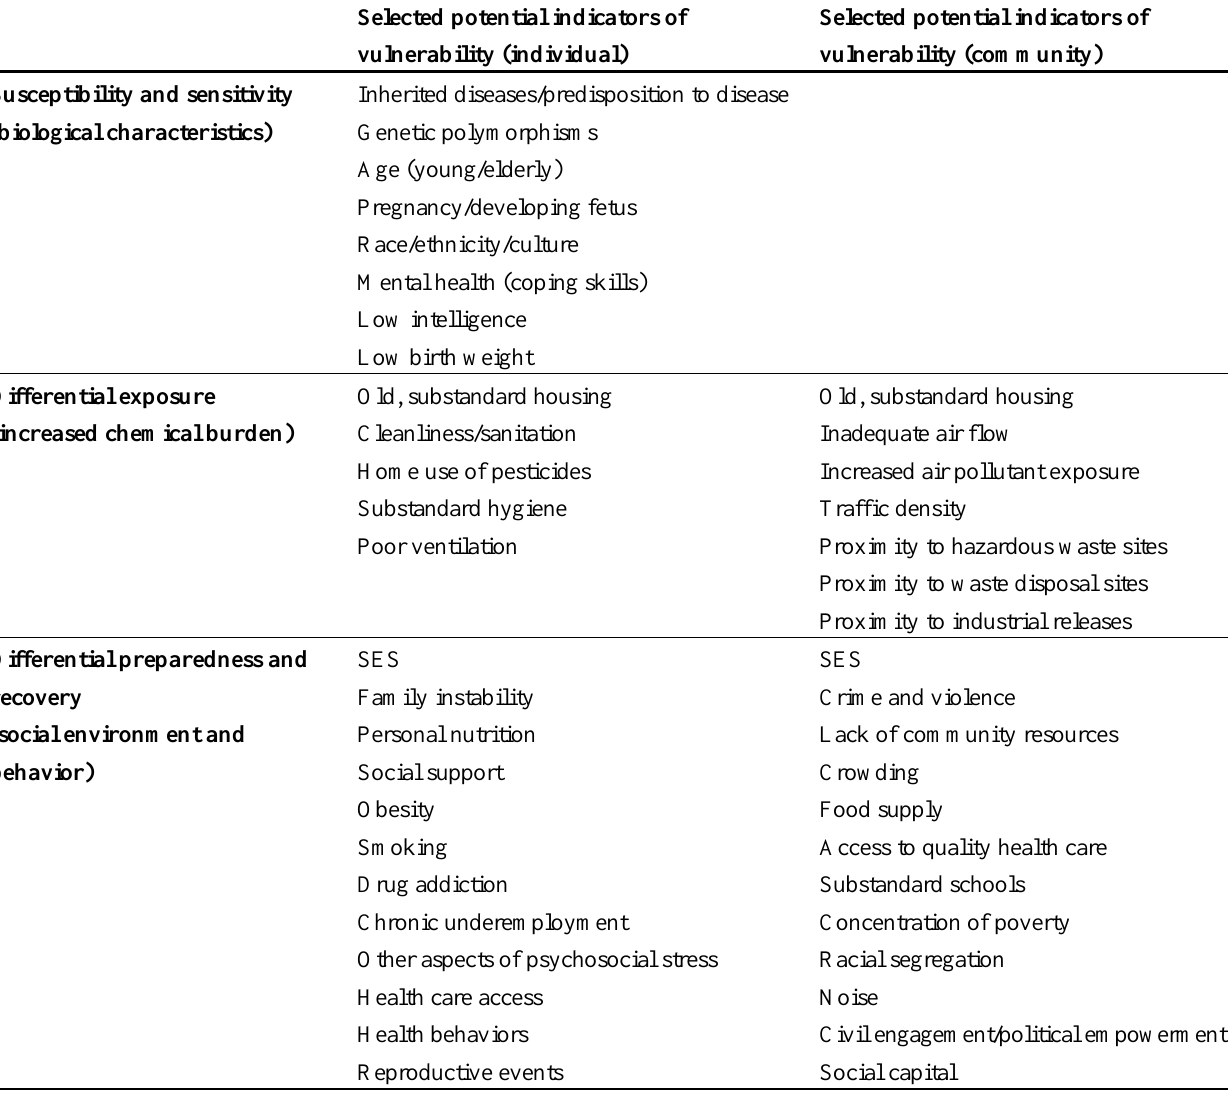
Table 2. Vulnerabilities related to biological sensitivity, differential exposure, and differential preparedness and